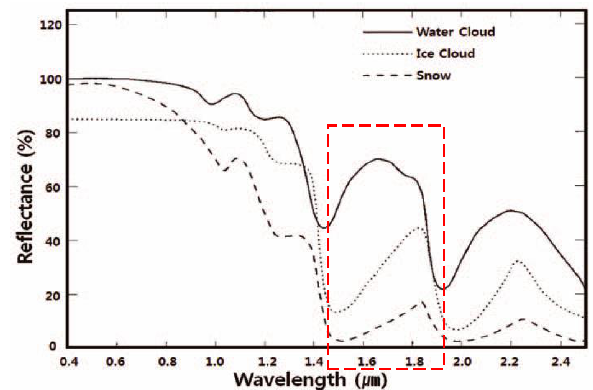
Figure 1. Spectral reflectance of Water Cloud, Ice Cloud and Snow surface (Gao, Han, Tsay, & Larsen, 1998). The red box depicts the SWIR spectrum.